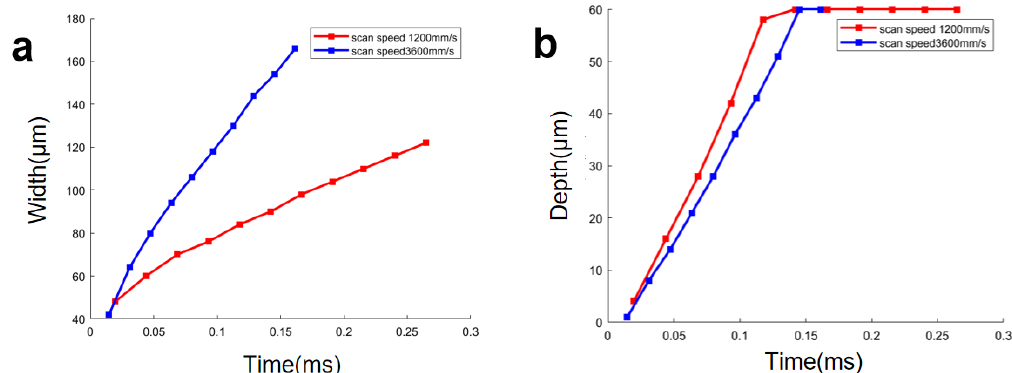
Figure 7. Effect of scanning speed on micro hole shape: ( a ) width; ( b ) depth.